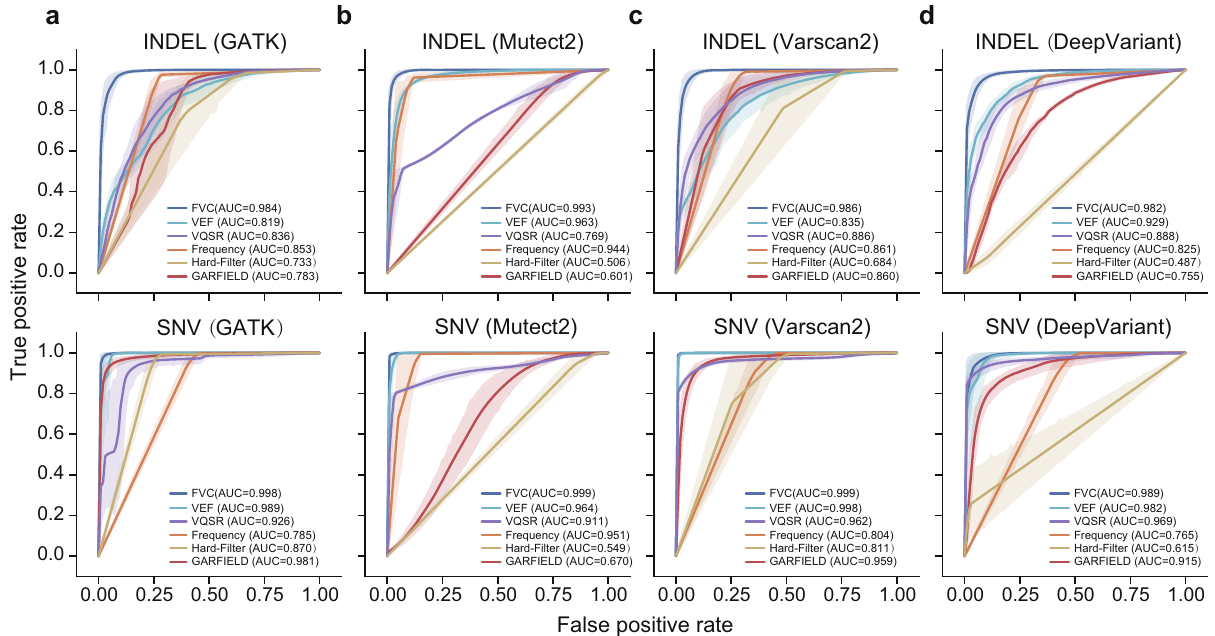
Fig. 2 The performance of different fi ltering methods when applied to SNV or INDEL variants. The SNV and INDEL variants used as testing data are derived from whole-genome sequencing datasets (HG001, HG003, HG004, and HG006) at 30× coverage. The performance of different methods is assessed on the SNV and INDEL variants identi fi ed by a GATK HaplotypeCaller; b Mutect2; c Varscan2; and d DeepVariant. The performance is assessed by using the leave-one-individual-out cross-validation method. The shaded area indicates the 95% con fi dence intervals ( n = 4 biologically independent samples). FVC consistently achieves the highest AUC score when applied to both SNV and INDEL variants.